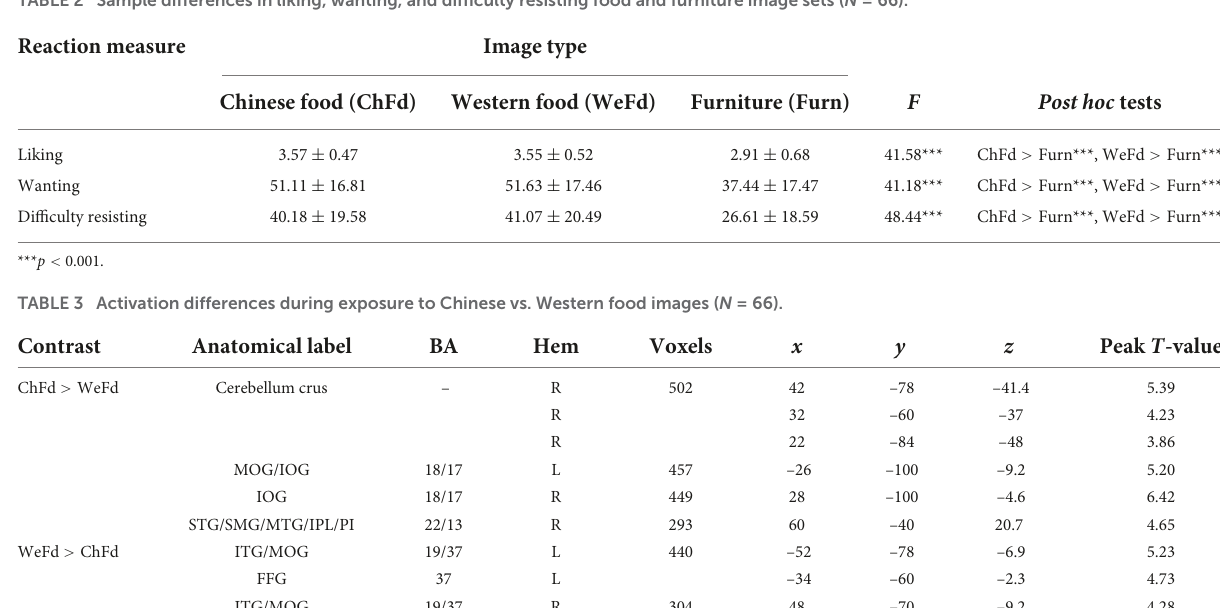
TABLE 2 Sample differences in liking, wanting, and difficulty resisting food and furniture image sets ( N = 66).